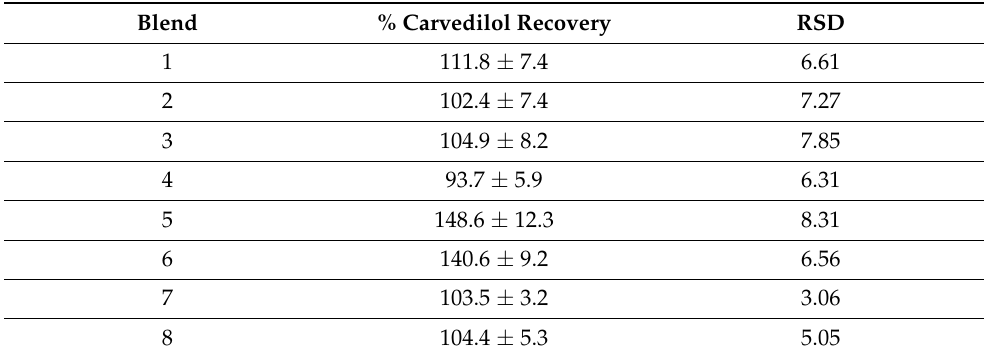
Table 5. Effect of processing parameters and blending order on percentage recovery of carvedilol.